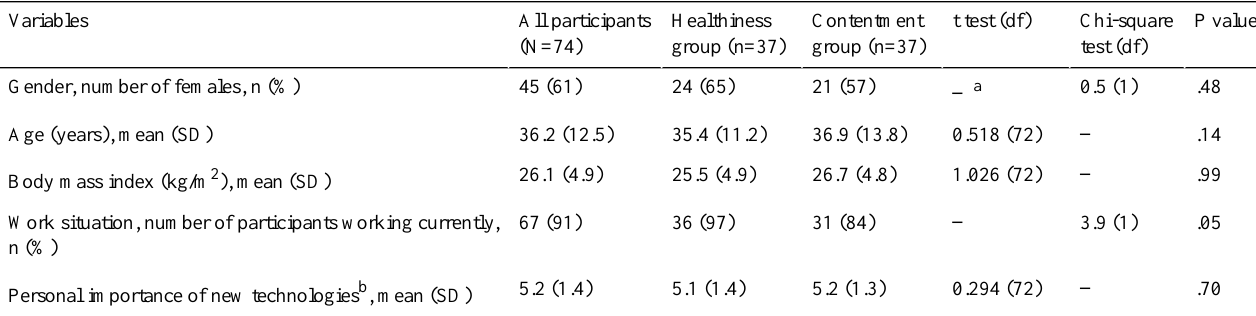
P valueChi-square